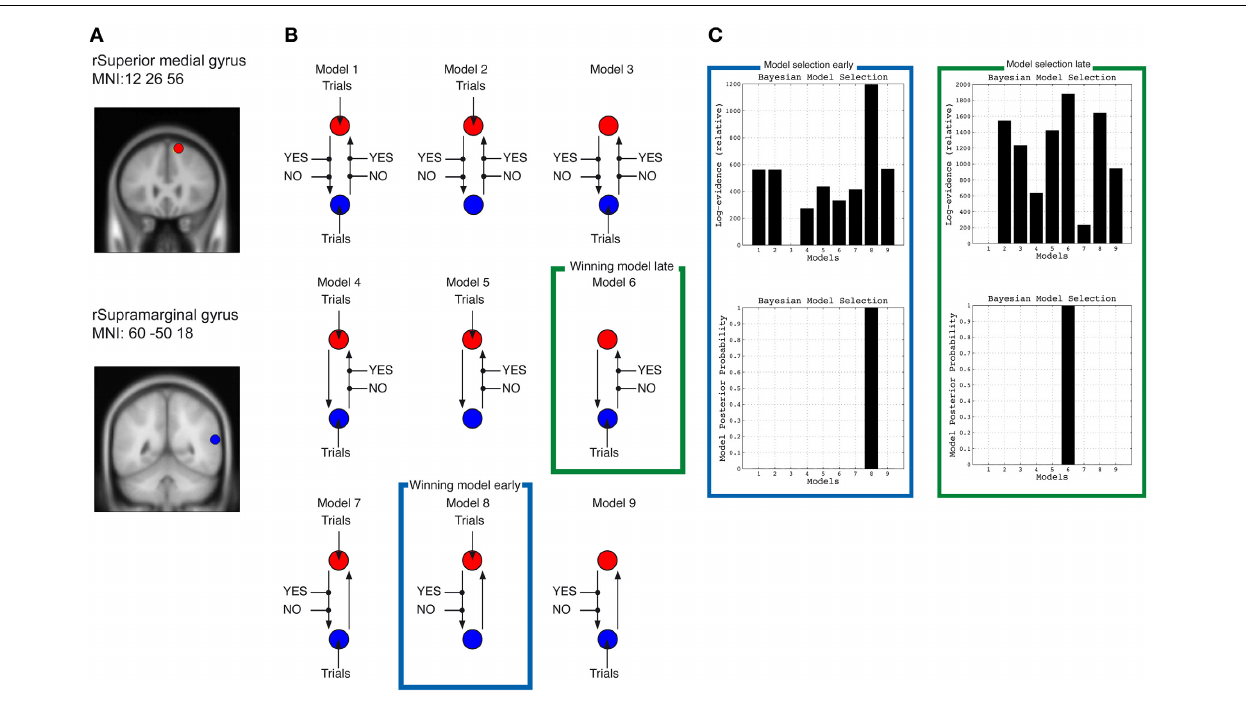
FIGURE 3 | Dynamic causal models. (A) Shows location of the two sources used for the DCM analyses in right medial frontal gyrus ∼ preSMA and right supramarginal gyrus ∼ IPC. (B) Shows the 9 different DCMs, and (C) the